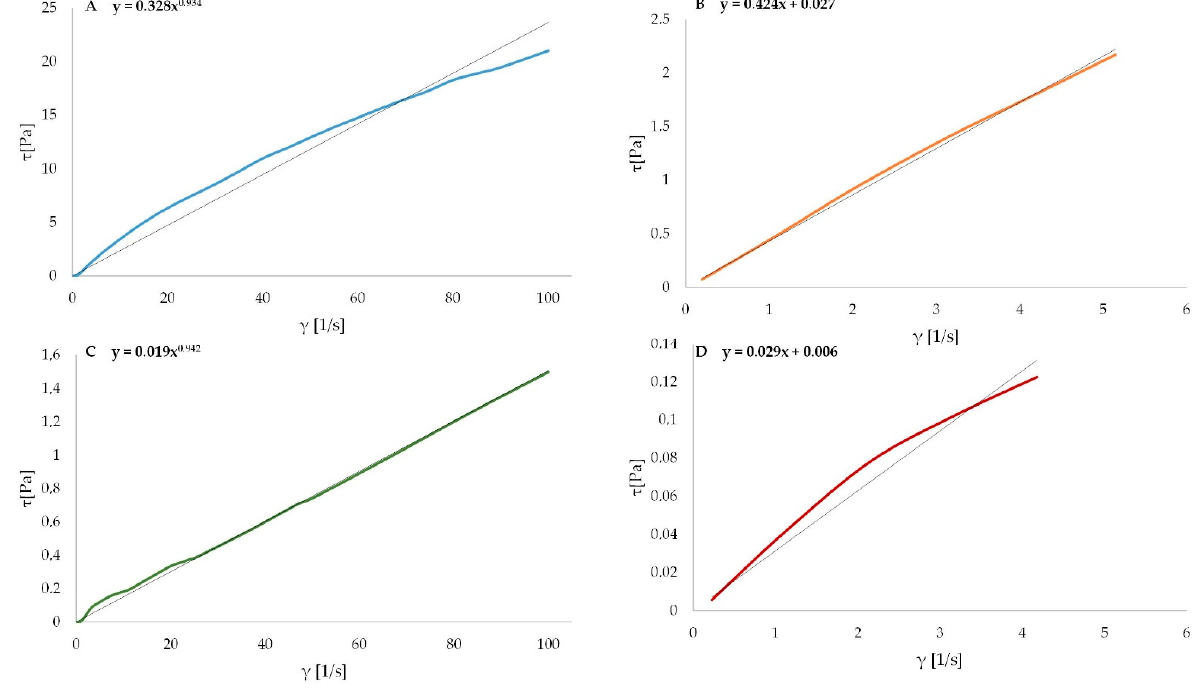
Figure 3. Flow curve ( A ) and yield stress determination ( B ) of SA and flow curve ( C ) and yield stress determination ( D )